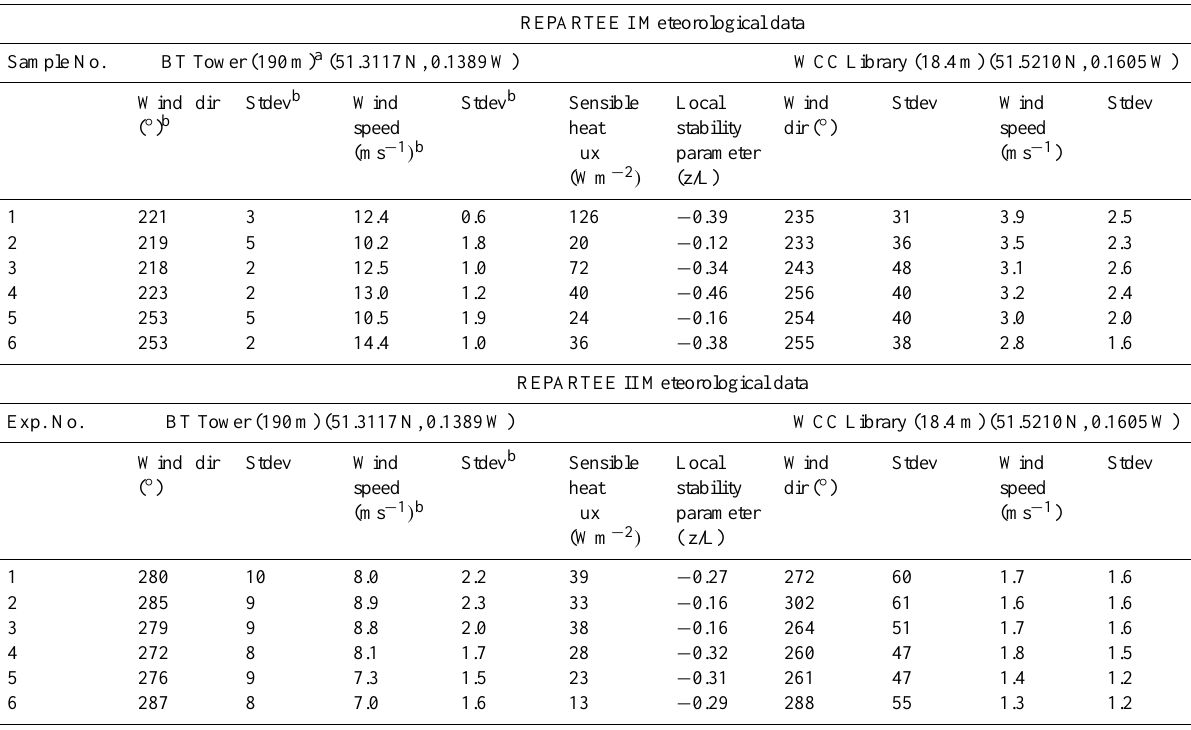
Table 3. Meteorological measurements made during REPARTEE I and II. Calculations of wind speed and direction are calculated from a sonic anemometer using double-rotation streamwise analysis (for full details see Wood et al., 2009; Wood et al., 2010). REPARTEE I Meteorological data Sample